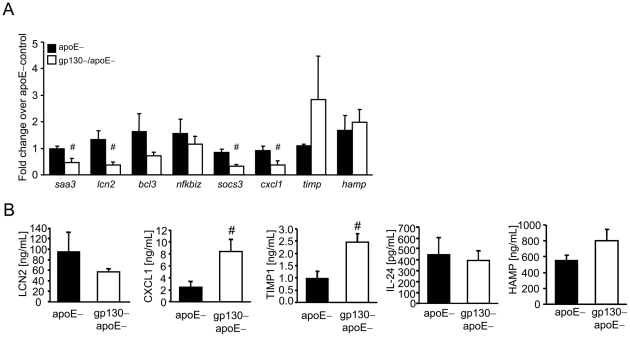
Analysis of gp130-regulated genes and soluble factors in a mouse model of atherosclerosis.(A) Quantitative real-time PCR of livers (n = 4–6 per genotype) taken from gp130–/apoE– and apoE– mice following feeding a cholesterol rich diet for 12 weeks. Saa3, lcn2, socs3 and cxcl1 mRNA-expression were significantly reduced in gp130-/apoE- mice compared to apoE-mice. (B) CXCL1, LCN2, TIMP-1, HAMP and IL-24 plasma levels from gp130–/apoE– and apoE– mice following feeding a cholesterol rich diet for 12 weeks. CXCL1 and TIMP-1 plasma levels are significantly increased in gp130–/apoE–- mice compared to apoE–mice, whereas LCN2 plasma levels are reduced within the same mice. IL-24 and HAMP plasma levels did not differ between the genotypes. Data are presented as mean±SEM of at least 6–10 mice/genotype; *P<0.05 vs. control, #p<0.05 vs. genotype.